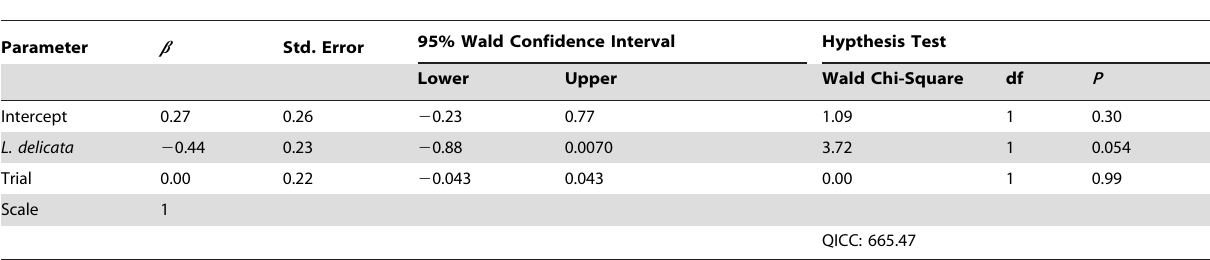
Table 3. Species differences in first turn direction across 15 maze trials.